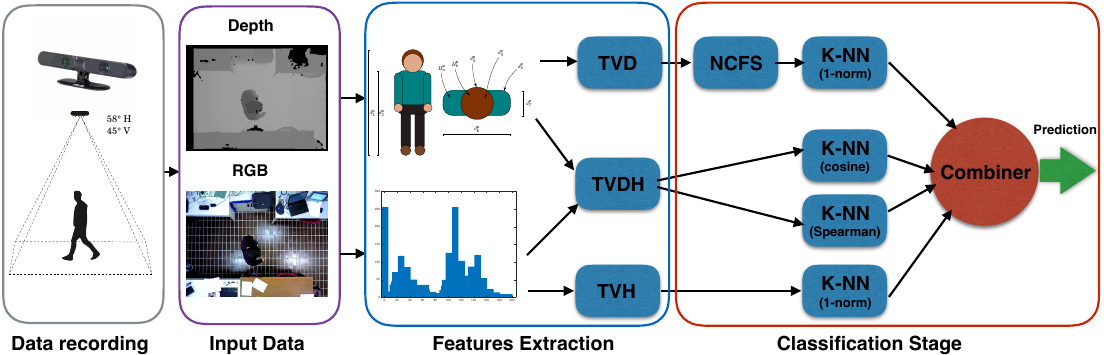
Figure 3. Overview of the proposed approach comprised of data recording, feature extraction and classification stage. NCFS, Neighborhood Component Feature